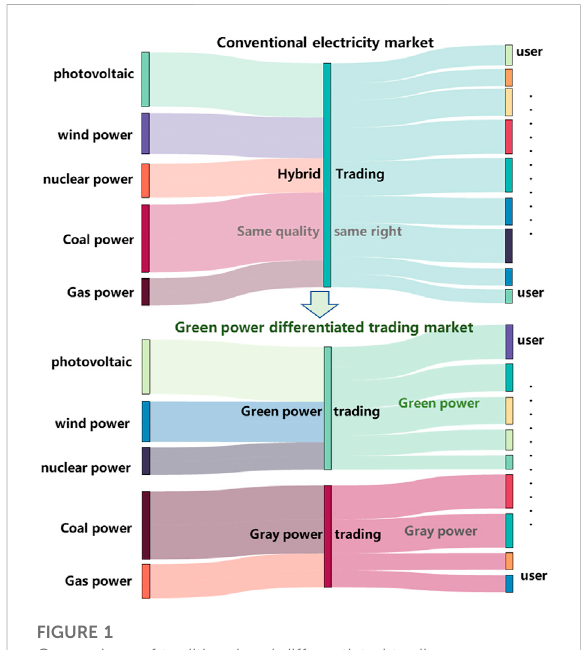
FIGURE 1 Comparison of traditional and differentiated